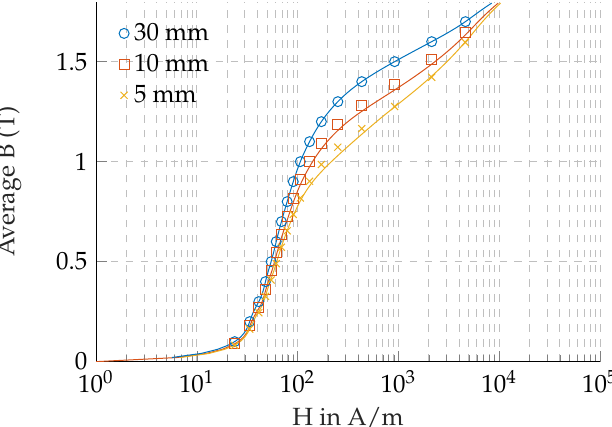
Figure 1. Schematic of the test specimen production for measurements.